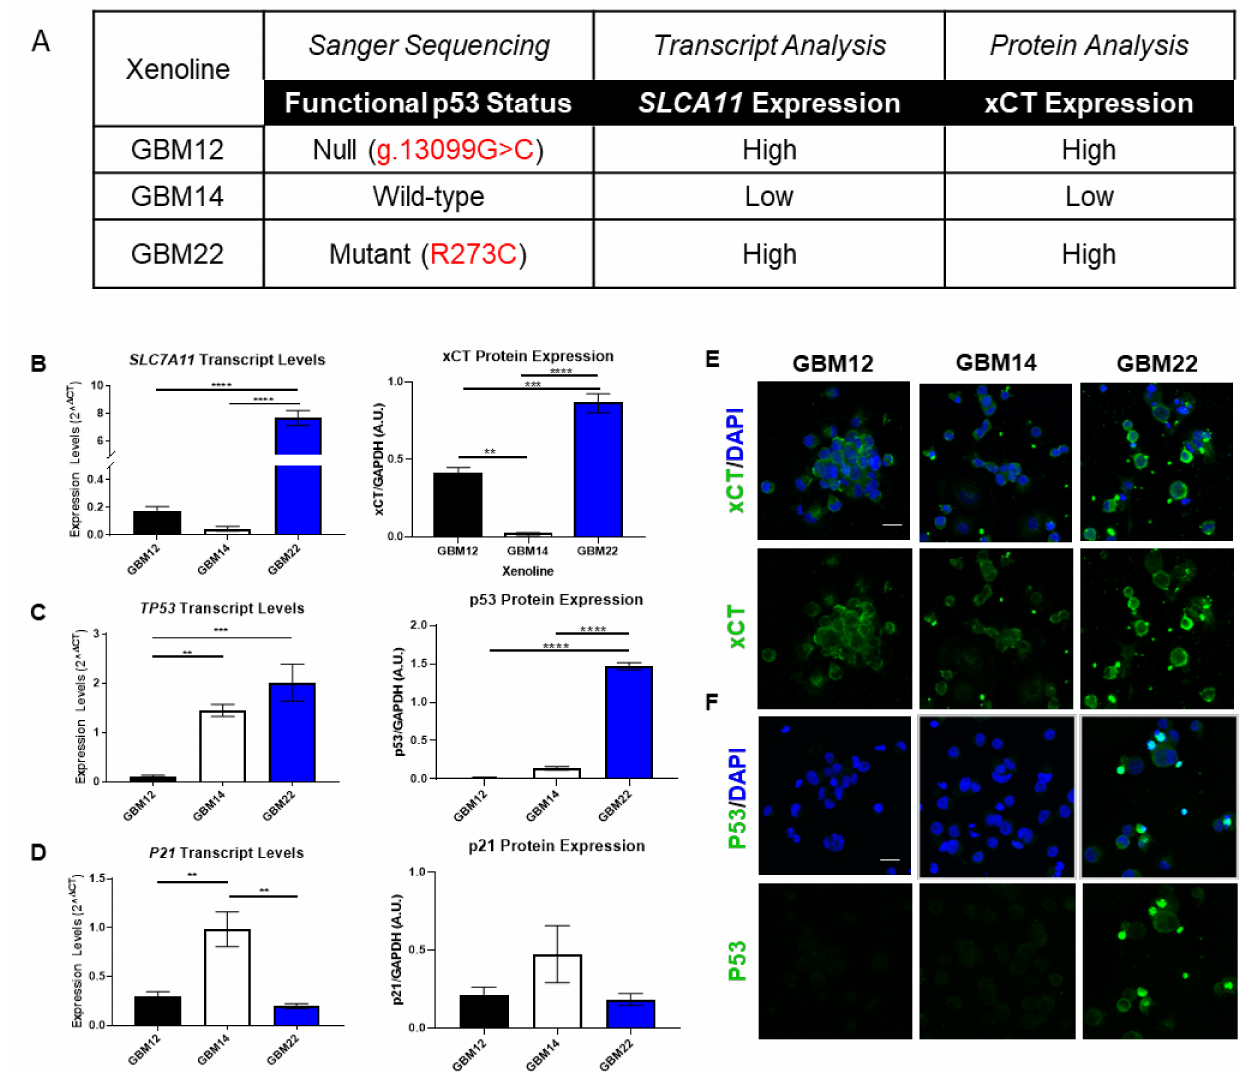
Figure 1. System x C- expression is inversely correlated with p53 functional status. ( A ) Sanger sequencing was performed on three different PDX GBM lines. Sequencing revealed different p53 statuses whereby GBM12 cells were p53-null, GBM14 cells were p53 wild-type, and GBM22 cells were mutant p53 (R273C). Transcript analysis and protein analysis results are also summarized in this table from experiments completed in the subsequent panels. ( B ) RT-qPCR and Western blot analysis of SLC7A11 and xCT expression in all three xenolines from ( A ). ( C ) RT-qPCR and Western blot analysis of TP53 and p53 expression in all three xenolines from ( A ). ( D ) RT-qPCR and Western blot analysis of P21 and p21 expression in all three xenolines from ( A ). All RT-qPCR and Western blot experiments are represented by at least three biological replicates. An ordinary one-way ANOVA with Tukey’s multiple comparisons test was performed. Error bars represent the mean ± standard error of the mean (S.E.M.). **** p < 0.0001, *** p < 0.001, ** p < 0.01. ( E , F ) All three xenolines from ( A ) were subjected to ICC analysis for xCT ( E ) and p53 ( F ) (green) and counter-stained with nuclear DAPI (blue). Note the characteristic accumulation of mutant p53 in the nucleus of GMB22 cells (( F ), right panels). Scale bar = 20 µ